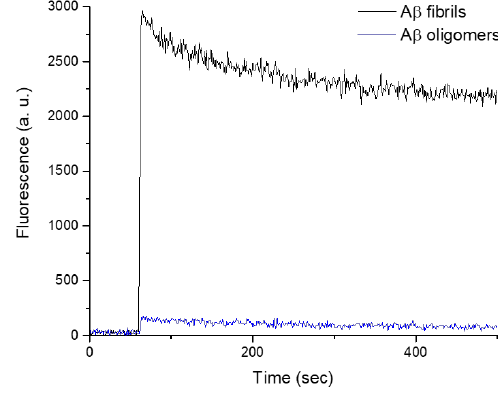
Figure 3. Characterization of Aβ oligomers and fibrils by ThT fluorescence. The build-up curve of the ThT fluorescence in function of time. The sample was added after 60 s for the ThT fluorescence curve.